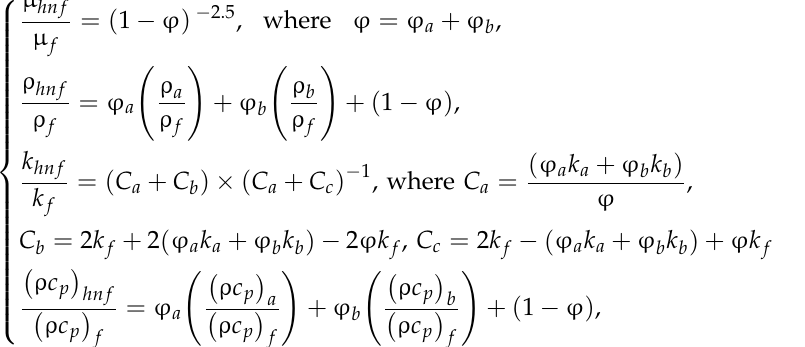
Figure 1. The physical geometry of the problem: ( a ) Rotating stretching disk, ( b ) Rotating shrinking disk.